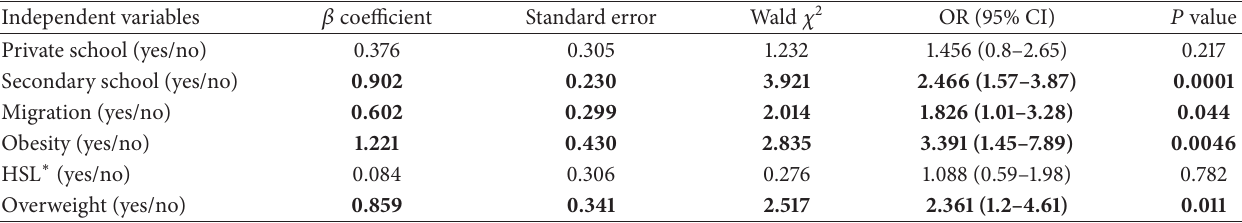
Table 4: Logistic regression to determine independent role of type of school, migration, obesity, HSL, and overweight on presence of pre-HT in